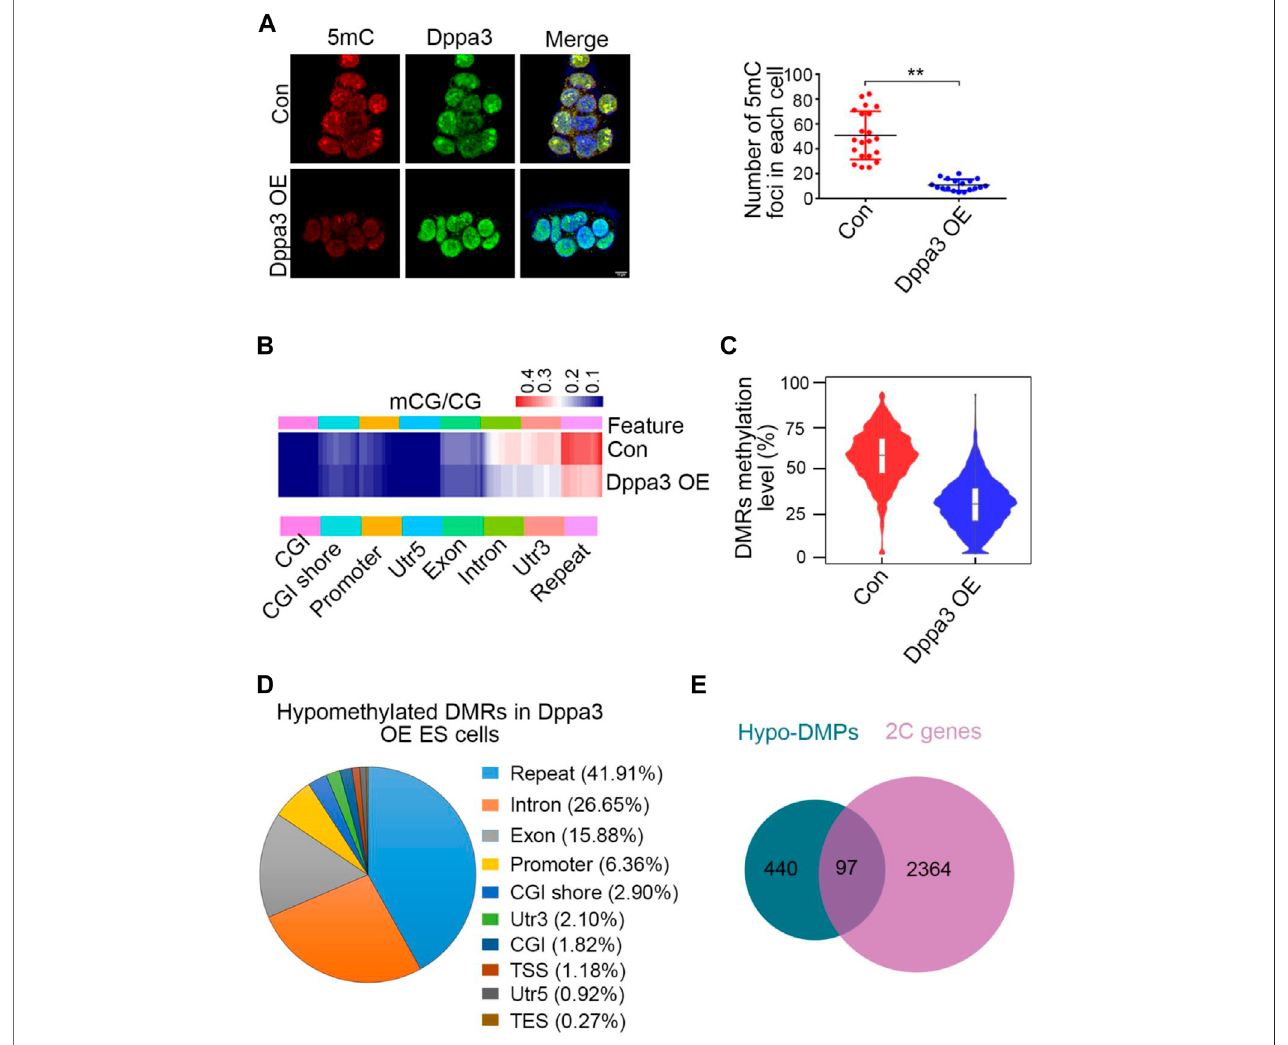
FIGURE3| Dppa3 overexpressionleadstoDNAdemethylationinESCs. (A) Immuno fl uorescencestainingfor5mC(red) andDppa3(green)in Dppa3 OEand Con ESCs. Right panel: quanti fi cation of 5mC foci in Dppa3 OE and Con ESCs. Scale bar represents 10 μ m. Data are presented as mean ± SEM (n = 3, ** p < 0.01). (B) Hierarchical clustering of differentially methylated sites between Dppa3 OE and control ESCs. Heat map displays methylation levels for whole genomes as measured by Reduced Representation Bisul fi te Sequencing separated into groups by genomic features. Each row indicates a CpG site and the color scale represents the methylation level. CGI, CpG island; TSS, transcription start site; TES, terminate sequence. (C) DMRs methylation levels as measured by RRBS in Dppa3 OE and control ESCs. Horizontal bars represent the median values. Inside is the boxplot. Violin fl anking represents the number of genes at this methylation level. (D) The genomic distribution of hypomethylated DMRs in Dppa3 OE ESCs. (E) Overlap between hypo-DMR-associated promoter genes (DMPs) and 2C-like